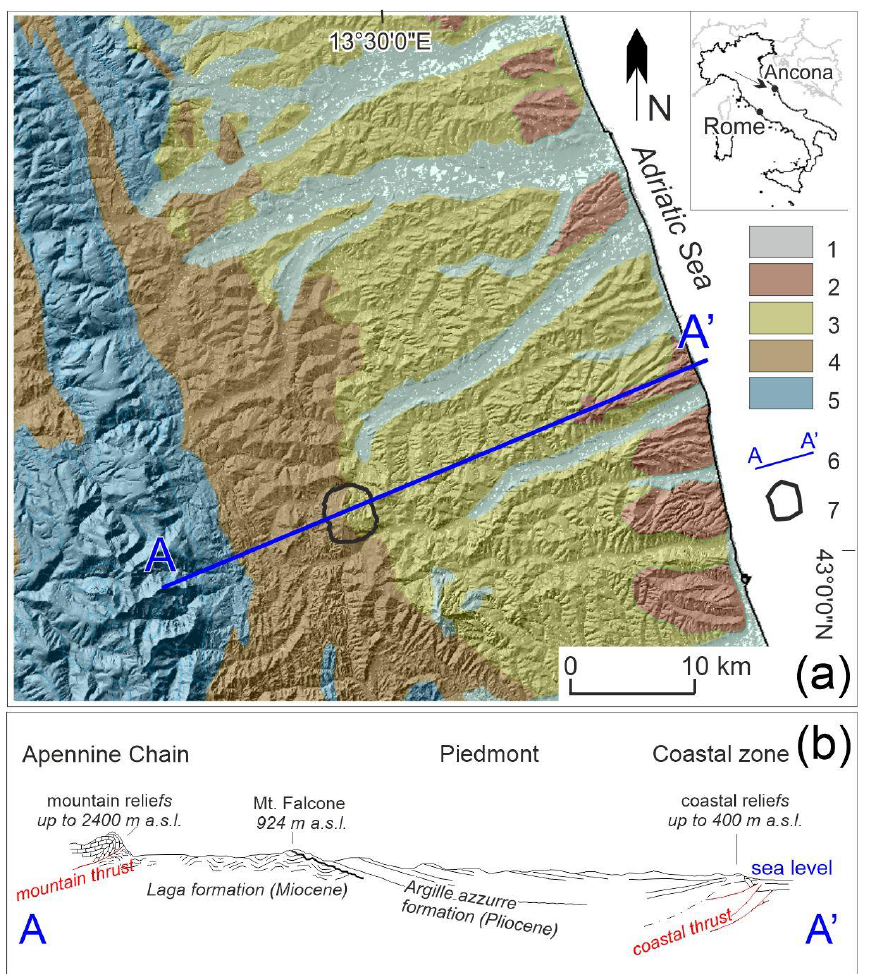
Figure 1. ( a ) Schematic geological map of the study sector: 1 — main continental deposits (Pleistocene – Holocene); 2 — sands and conglomerates (Pliocene – Pleistocene); 3 — clays and sands (Pliocene – Pleistocene); 4 — arenaceous-marly-clayey turbidites (late Miocene); 5 — limestones, marly limestones and marls (early Jurassic – Oligocene); 6 — trace of cross-section shown in Figure 1b; 7 — study area (see Figure 4). ( b ) Schematic geological cross-section from the Apennine chain to the Adriatic Sea, modified from [42].